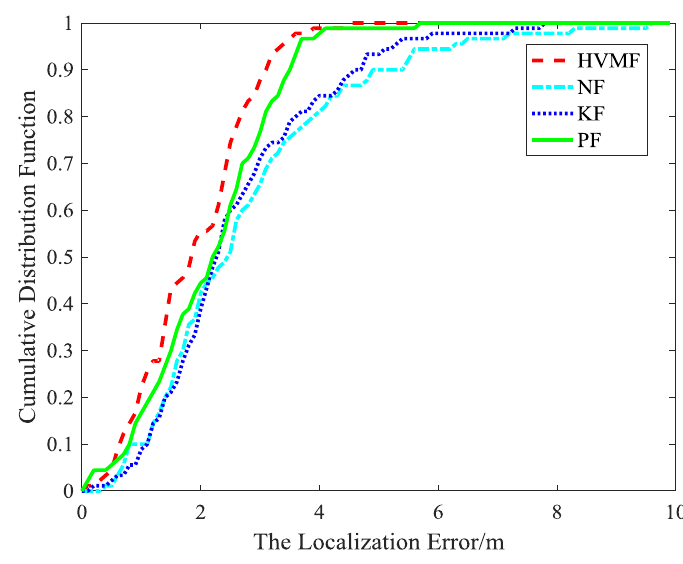
Figure 18. The localization error versus CDF.